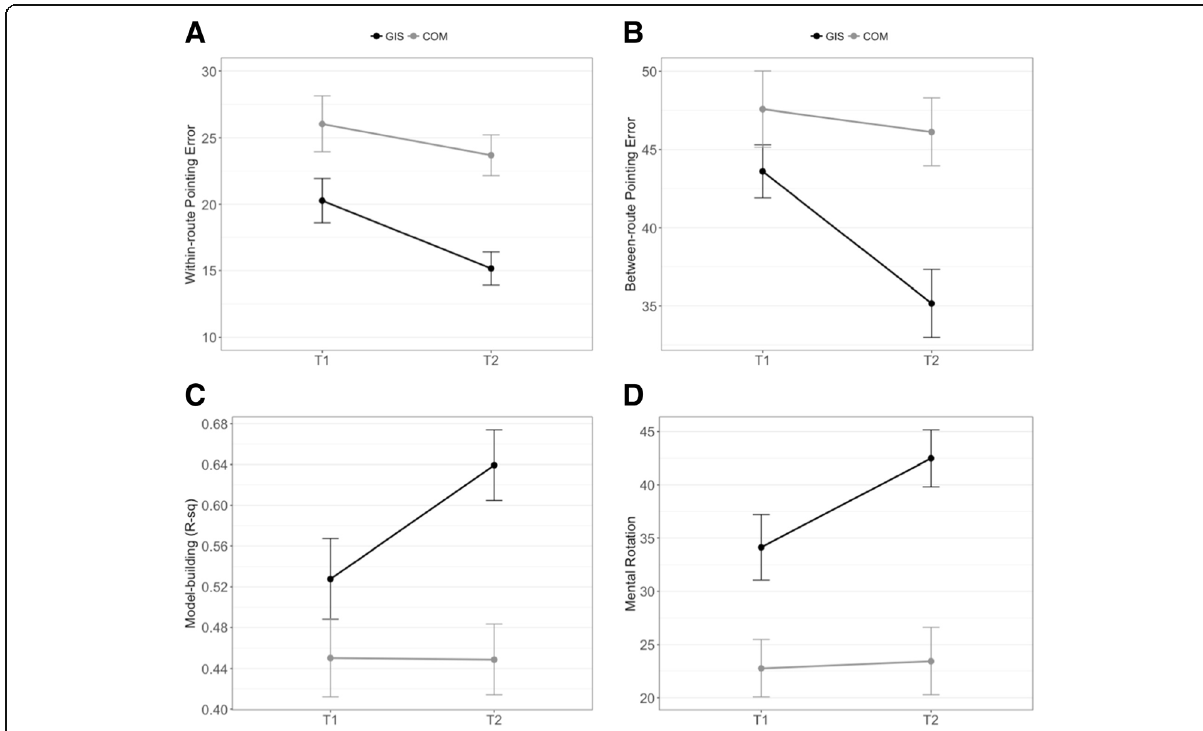
Fig. 5 Change in large-scale navigation and small-scale mental rotation tasks, grouped by participant course. a Within-route pointing error. b Between-route pointing error. c Model-building (R 2 value). d Mental rotation skill. Overall, GIS participants significantly outperformed COM participants and there was significant improvement in both groups from T1 to T2. In addition, GIS participants improved at a faster rate than COM participants on all measures except the within-route pointing task. Error bars reflect ±1 standard error of the mean. COM Communication, GIS Geographic Information Systems, T1 pre test (start of academic semester), T2 post test (end of academic semester). For within- and between- pointing errors, a low value (error) indicates high